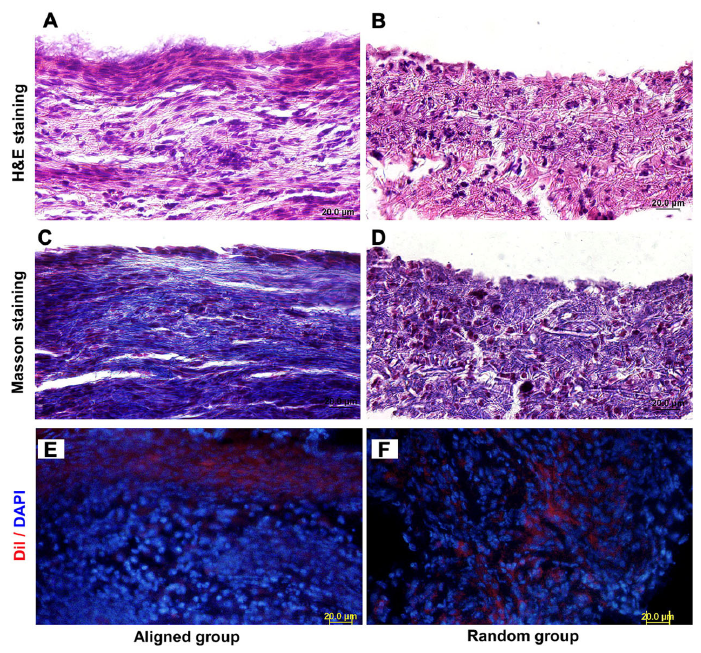
Figure 5. As compared to random scaffolds, aligned scaffolds can better promote tendon tissue regeneration in vivo. Aligned scaffolds induced a spindle-shaped morphology of cells ( A )